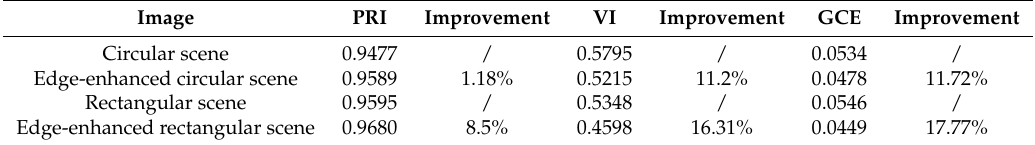
Figure 12. The imaging and image segmentation result of the complicated area. ( a ) Original image; ( b ) image segmentation result of the original image; ( c ) edge-enhanced SAR image; ( d ) image segmentation result of the edge-enhanced SAR image. Table 4. Supervised evaluation of image segmentation. Probabilistic Rand index (PRI), variability index (VI), and global consistency error